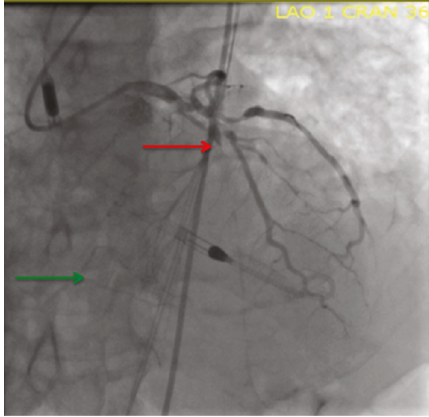
Figure 1: Coronary angiography demonstrating an occluded LAD (red arrow) with collaterals to the RCA (green